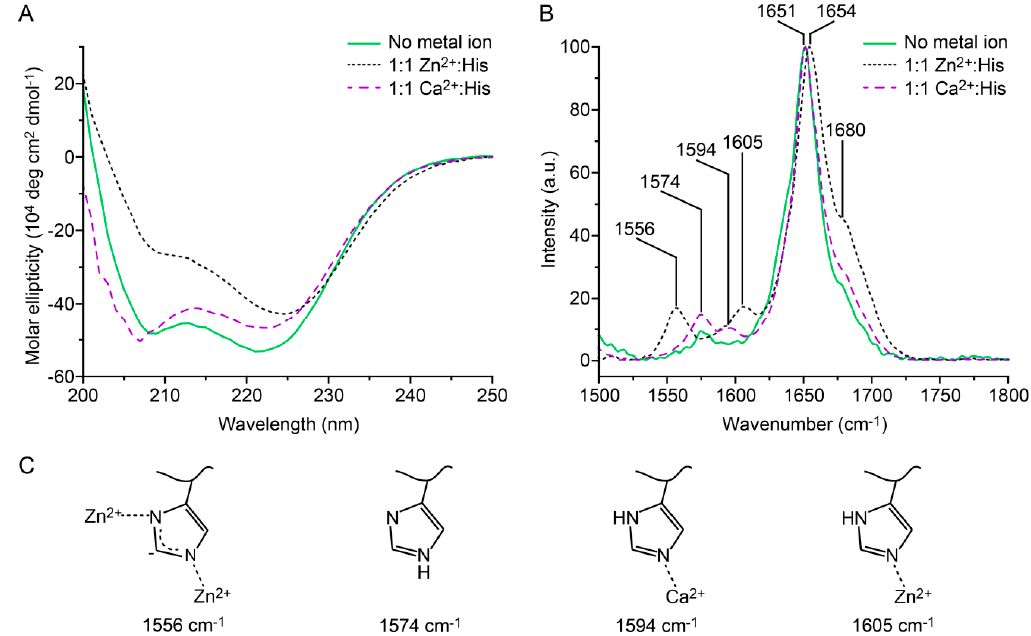
Figure 2. Circular dichroism and Raman spectroscopy of A 4H3 B 4H3 . ( A ) Circular dichroism spectra measured in noncoordinating PIPPS buffer. ( B ) Raman spectroscopy performed on dried thin films of the coiled coil (CC). With both techniques, the CC was studied in the absence of metal ions and in the presence of 1:1 Zn 2+ :His or 1:1 Ca 2+ :His (negative control). ( C ) Scheme of the protonation and coordination states of His observed in Raman spectroscopy. The amide I peaks at 1651 cm − 1 and 1654 cm − 1 indicate an α -helical secondary structure. The assignment of the peak at 1680 cm − 1 is less clear and can indicate the existence of β -sheet or unordered secondary structures [41–43].